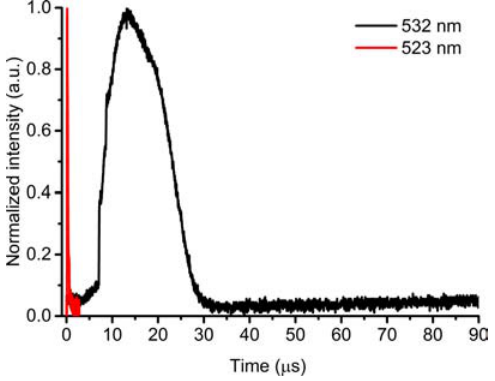
Fig. 1. The normalized laser pulse shape of 523 nm and 532 nm pulsed laser at the repetition rate of 10